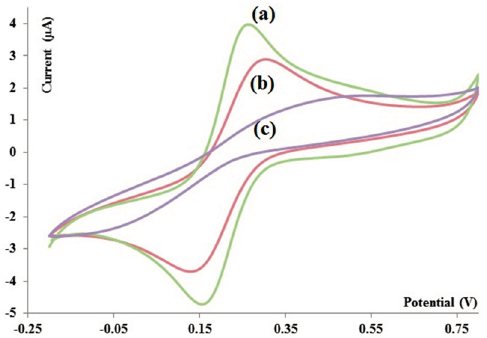
Figure 7. Voltammogram of bare ( a ) Au; ( b ) Au coated with 11MUA/EDC/NHS and ( c ) Au coated with 11MUA/EDC/NHS/APT/BSA in K 3 [Fe(CN) 6 ] 1 mM in PBS (pH 7.4) vs.